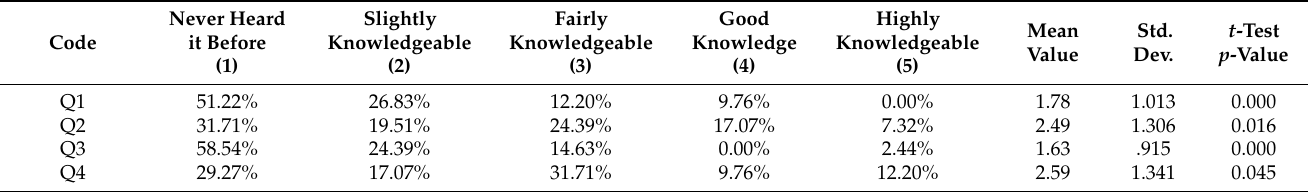
Table 2. Descriptive statistics for measuring the cognizance of the IPD approach, BIM, and Relational